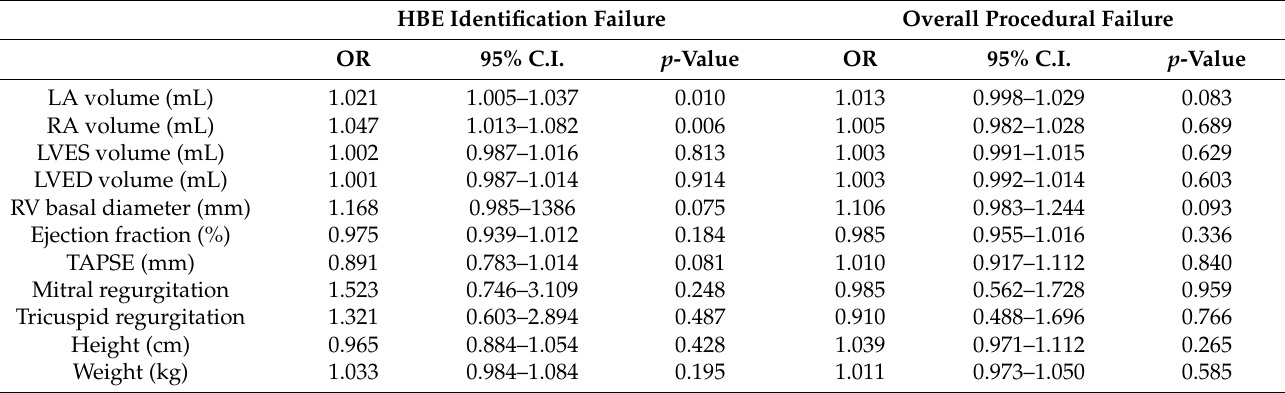
Table 3. Logistic regression analysis adjusted for weight and height for procedural outcomes.